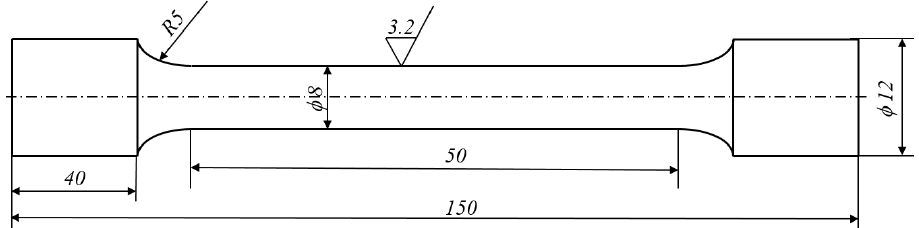
Figure 1. Shape and dimensions of samples for static tensile testing.